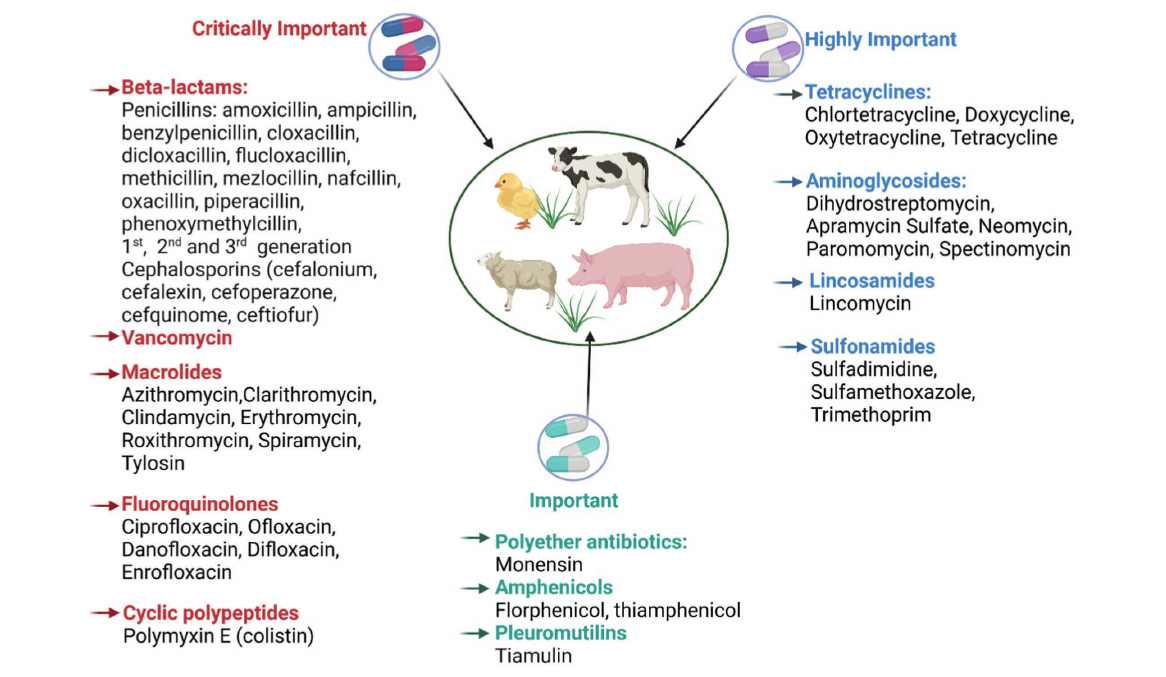
FIGURE 2 Major classes of antibiotics and representatives used in livestock production. The figure is created using